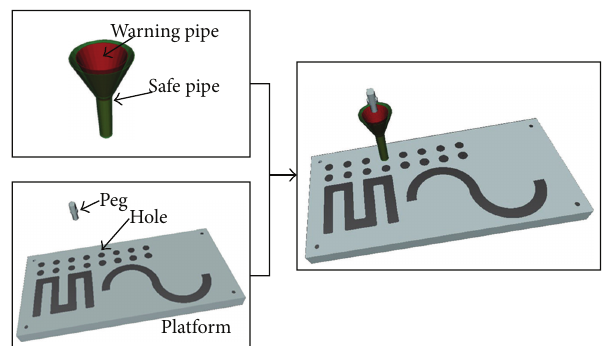
Figure 1: Geometric relation for spatial motion